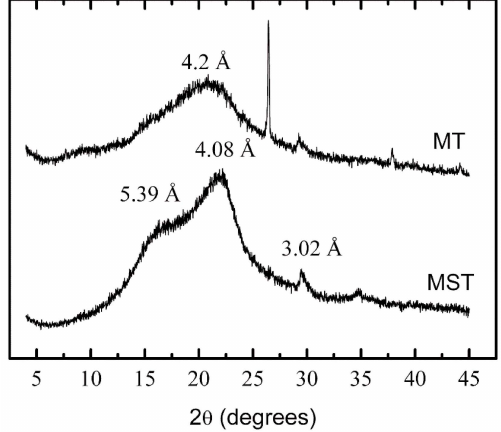
Figure 4. X-ray diffraction patterns of untreated (MST) and treated (MT) castor oil